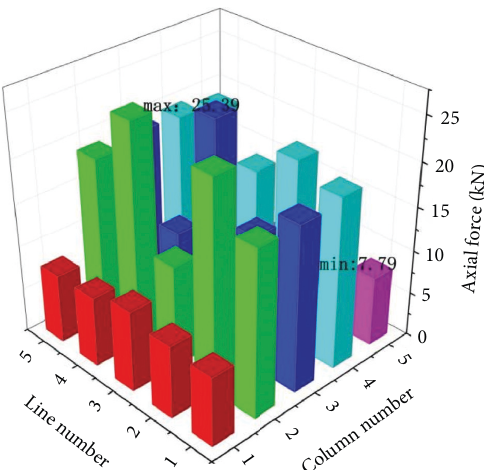
Figure 12: Axial force distribution of 25 vertical poles in sample C1-1.